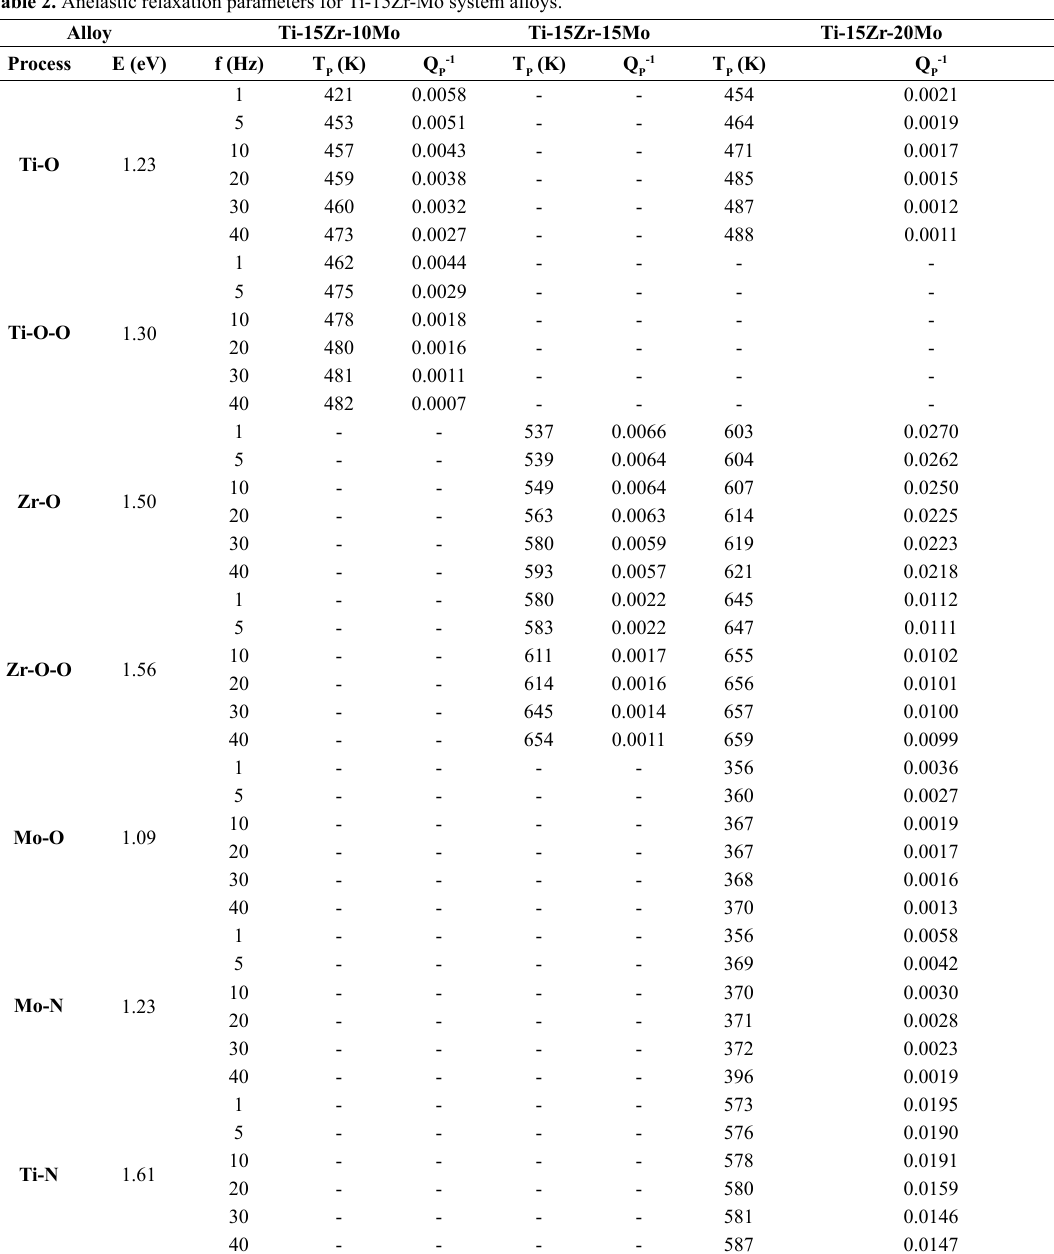
Table 2. Anelastic relaxation parameters for Ti-15Zr-Mo system alloys. Alloy Process